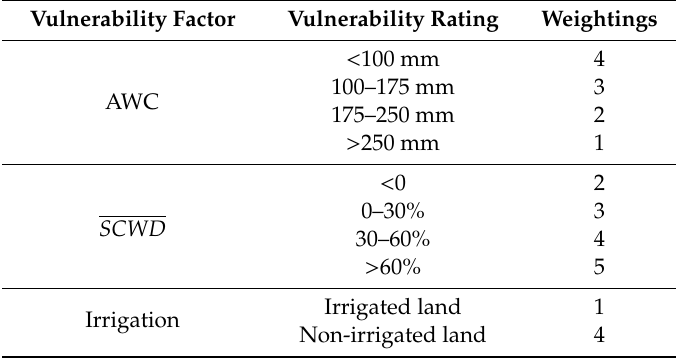
Table 4. Weightings for the drought vulnerability assessment factors in the